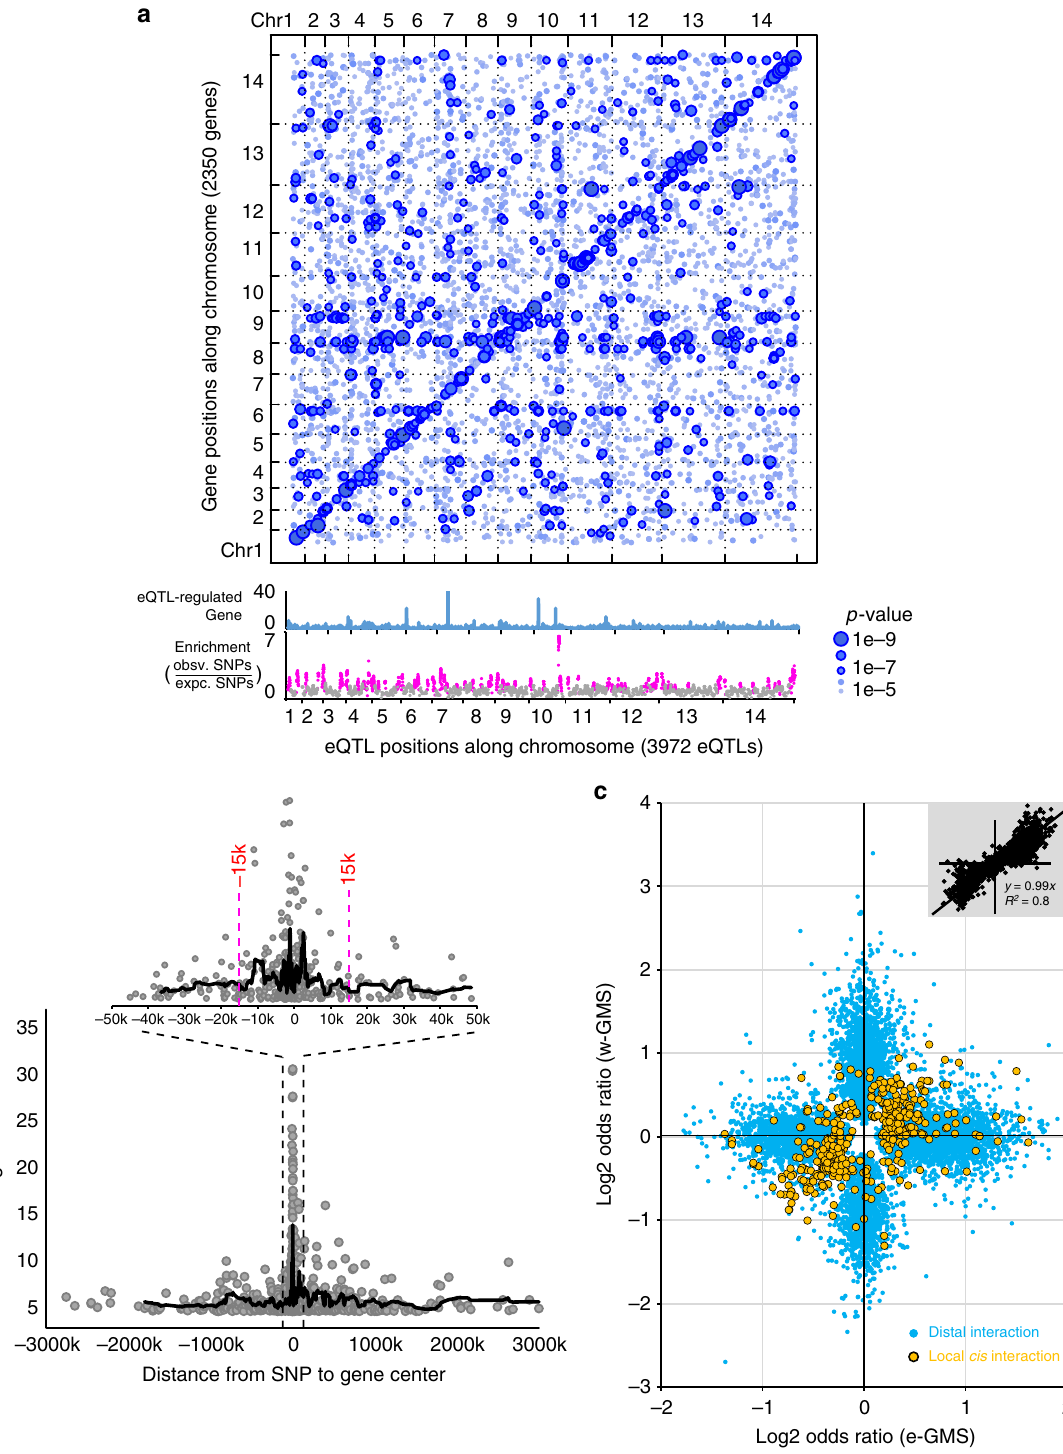
Fig. 3 eQTL analysis for P. falciparum isolates in the GMS. a Scatter plot of 5575 high-con fi dence SNP-expression linkages with 2350 gene expression ( y axis ) against 3972 eQTLs ( x axis ). The statistical signi fi cance of each linkage is represented by the size of dot and the intensity of blue. The bar graph represents target genes for each eQTL. The scatter plot below represents eQTL enrichment along the chromosomes. The enrichment score was calculated as a ratio of observed and expected eQTL counts within a 50 kb window. The magenta dots denote eQTL hotspots. b Intra-chromosomal linkages are plotted as the signi fi cance (log transformed p -values) against the distance (between eQTL and target gene) for each linkage. The black lines represent average curves for a sliding window of 20 eQTLs. c Differential eQTL effects in isolates of (sub)regions of the GMS. LOD values are plotted for the w -GMS eQTLs against the e -GMS eQTLs where yellow dots stand for the local cis linkages and blue for the distal. The top right inset represents LOD values resulted from sub-sampling analysis of the 5575 high-con fi dence linkages in e- GMS